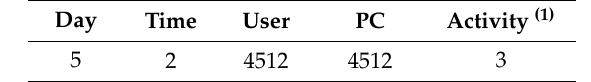
Table 3. Encoded features at pre-processing